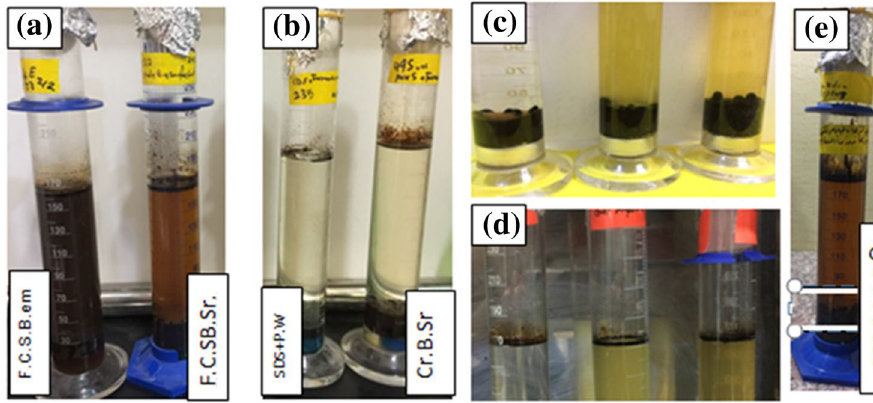
Drop‑collapse test The two selected strains showed a positive as shown in Fig. 6. The supernatant droplets containing the biosur- factant spread or even collapse due to reduced force or tension between the liquid surfaces and the hydrophobic surface (Walter et al. 2010), while the distilled water as a negative control remains stable on the surface because the